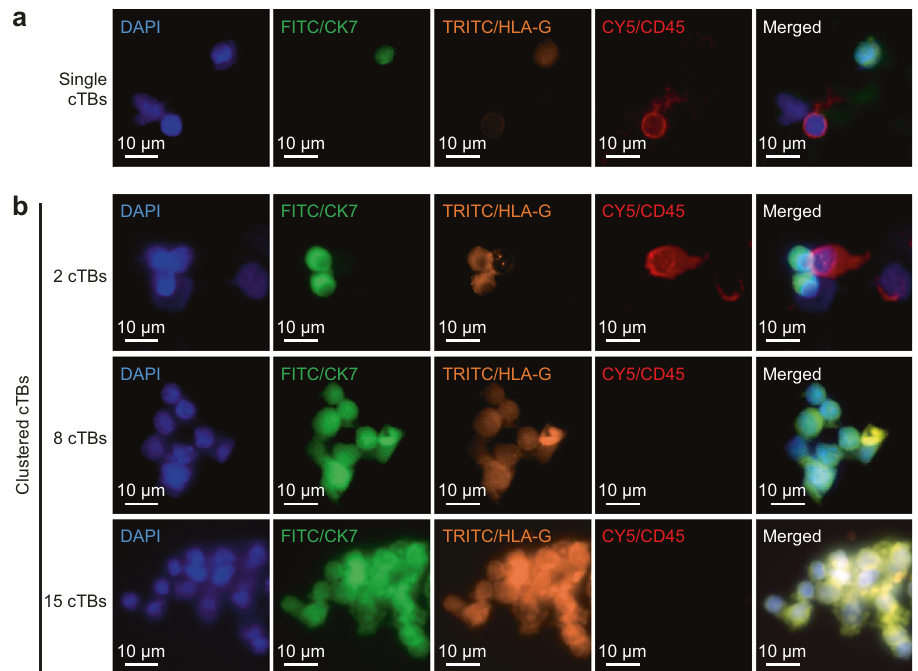
Fig. 4 Characterization and enumeration of single and clustered cTBs isolated from blood samples collected from pregnant women. Representative immuno fl uorescent images of a single and b clustered cTBs in different sizes of cTB-clusters shown at ×40 magni fi cation. Blue: DAPI stained nuclei; green: FITC stained CK7; orange: TRITC stained HLA-G; red: CY5 stained CD45. Scale bar, 10 µ m. Data are representatives of four independent